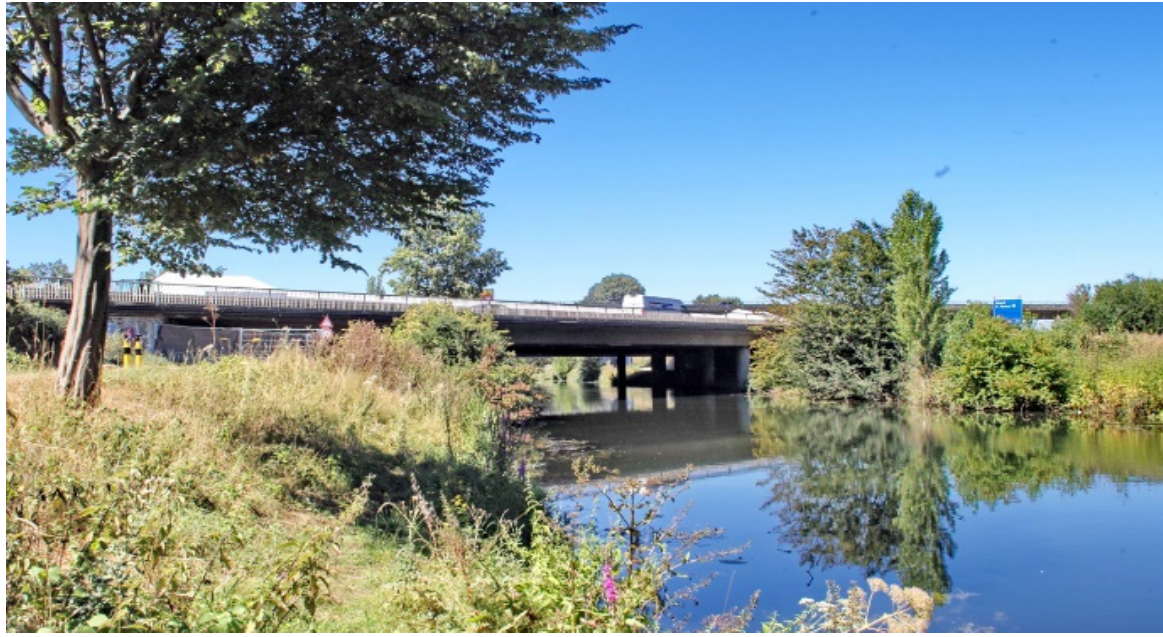
Figure 9. View of the motorway bridge over the river Nidda. (Photo: Oliver Steinbock).